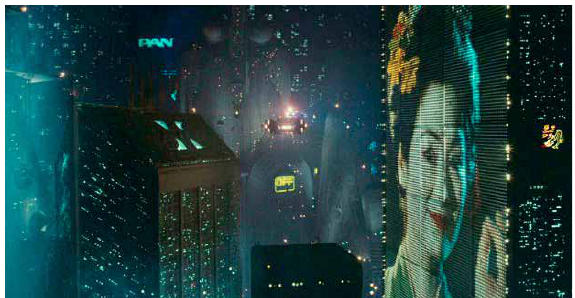
fig. 13. Blade Runner : giant TV screen on a